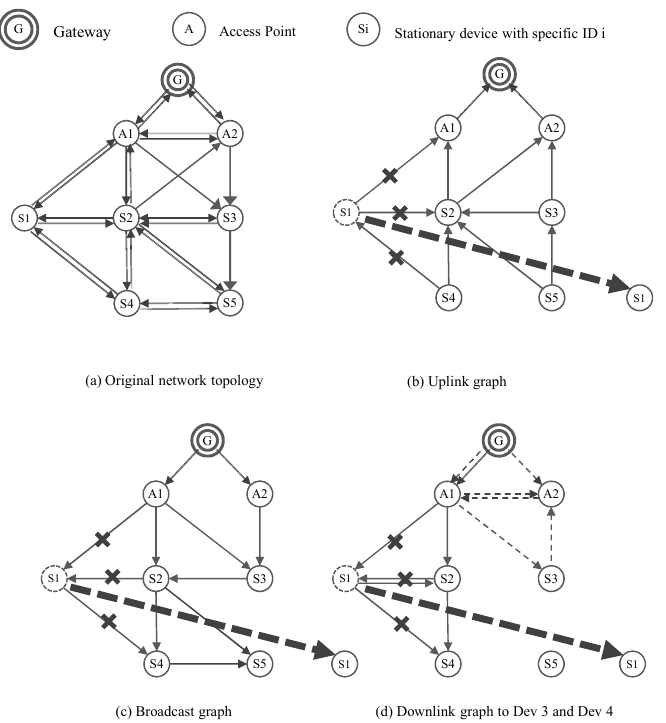
Figure 1. An example of network changes problem on the constructed graphs by the authors of